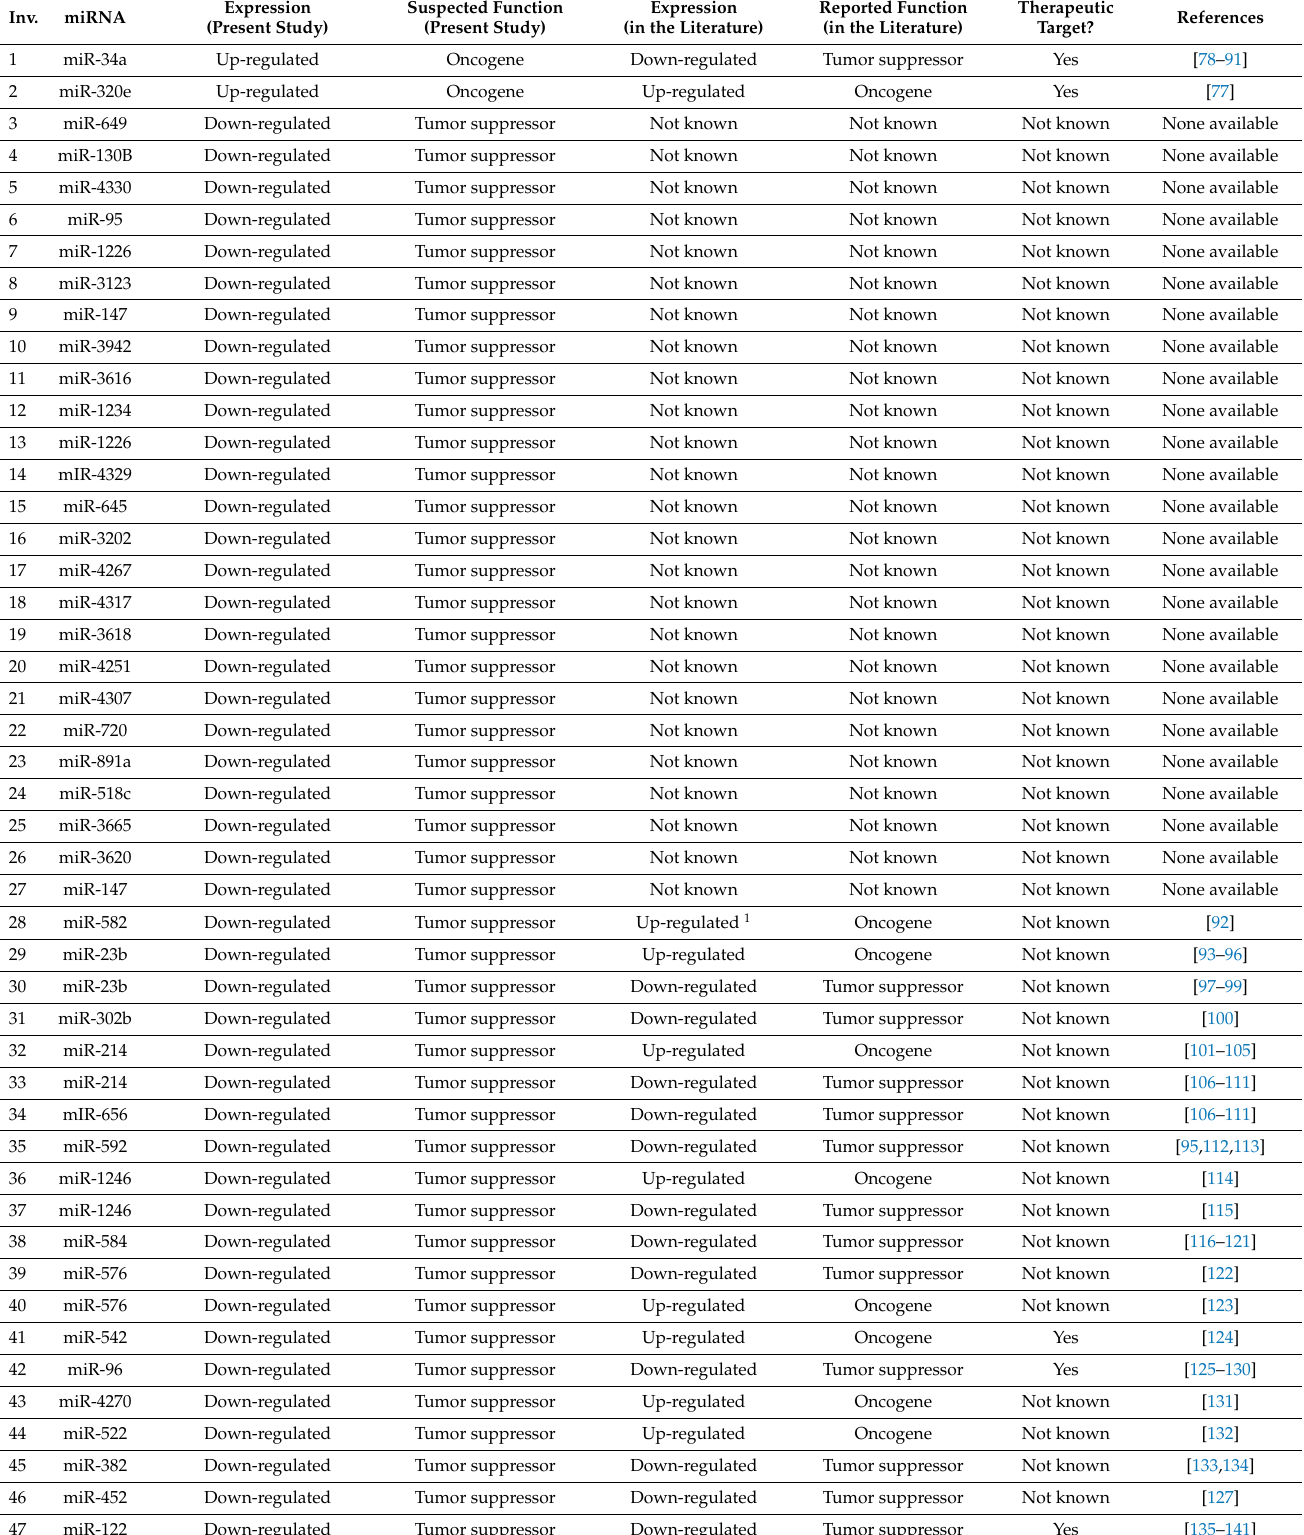
Table 5. Comparative table of the miRNAs identified in the present study and those reported in the literature with respect to their expressional profiles and reported